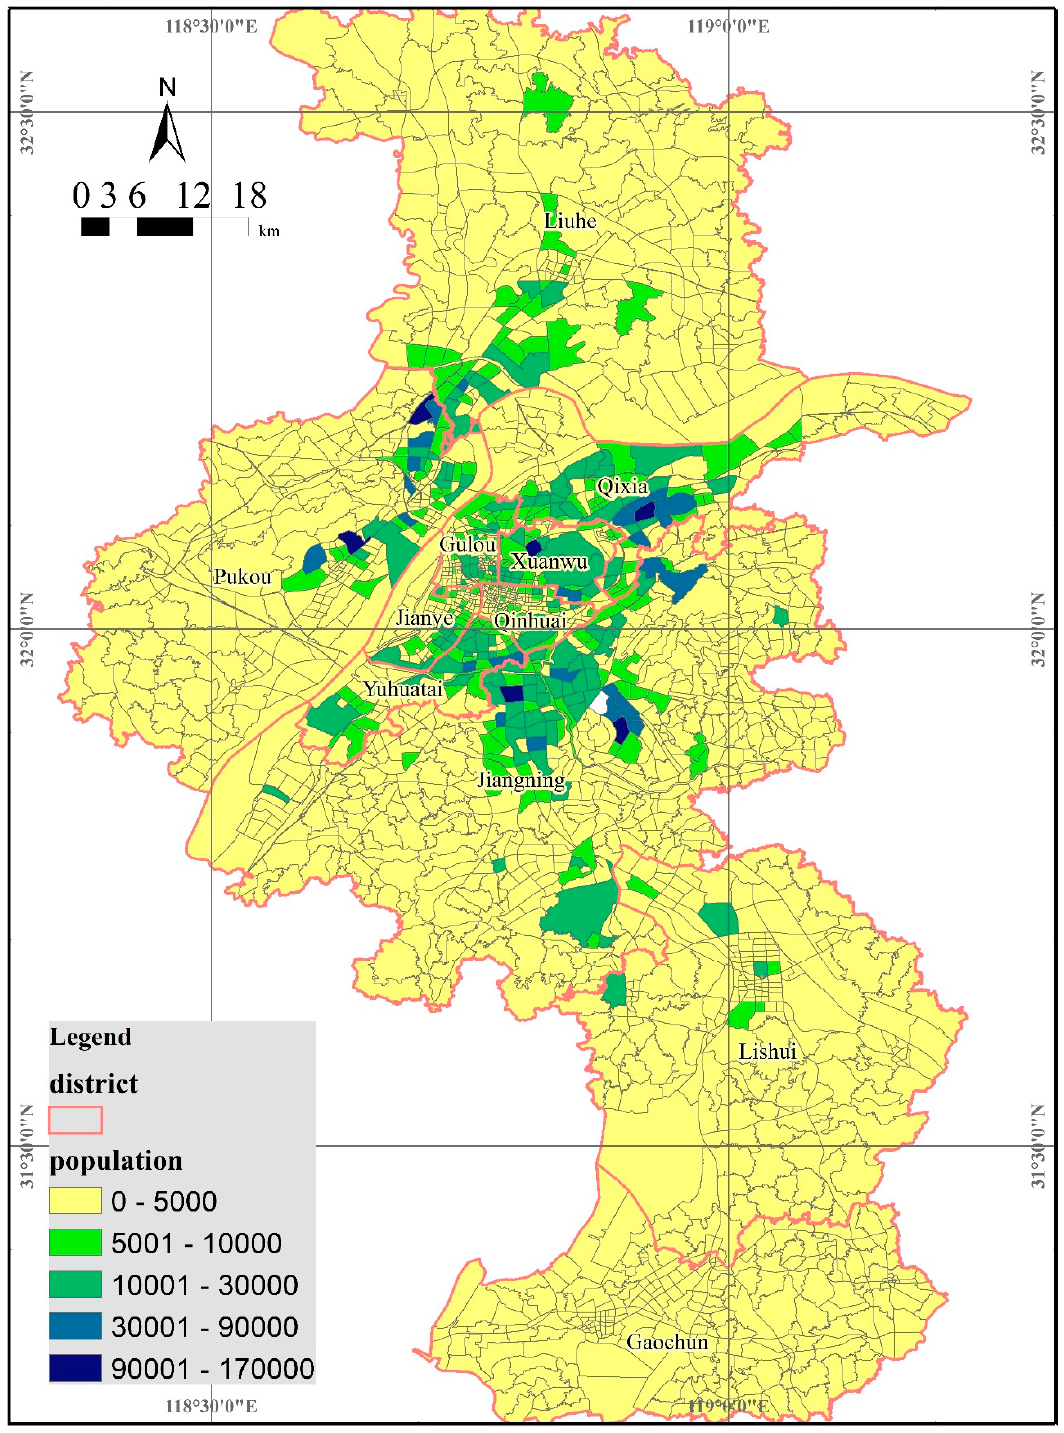
Figure 8. The spatial distribution map of Nanjing's child population (high-resolution figure can be seen from https://figshare.com/s/7fc7a00e868a9c71ac37).